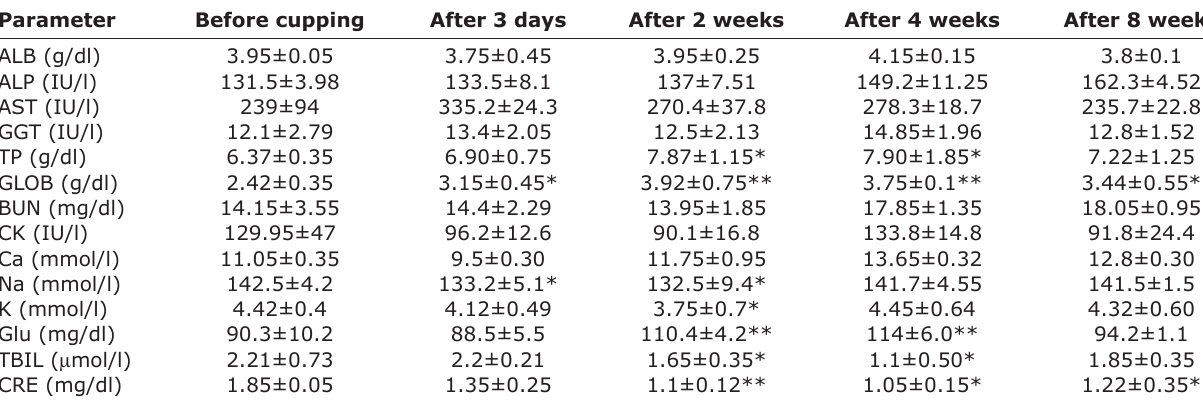
Table-2: Mean and SEM of the serum biochemical parameters in Arabian horses before and after cupping.